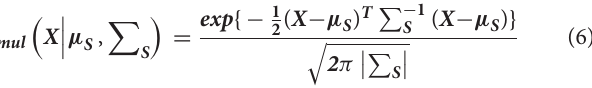
matrix are sorted in a descendant order. The second step is to add the sorted values to the norm matrix. The ratio between the newly formed matrices to the matrix norm is compared to a threshold value (p ǫ [0,1]). Holding 99% of the contained information ( p = 0.99) is the constraint that is used in our study to get rid of the lowest contributing bands. Applying the former procedure, we found out that the highest contributing bands are whose central wavelength: (728, 688, 695, 719, and 703 nm), while the lowest ones are (443, 451, 453, 438, and 455